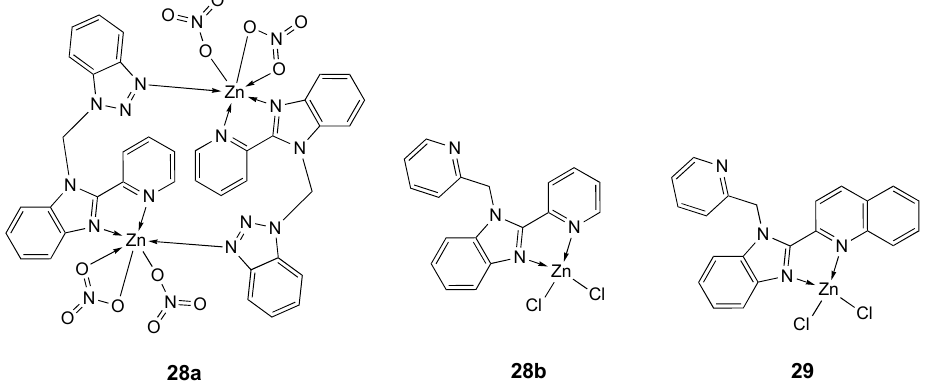
Figure 16. Structure of the zinc complexes 28a , 28b and 29 . Table 8. IC 50 values ( µ M) for zinc complexes 28a , 28b , ligands L 28a,b and reference cisplatin against di ff erent tumor cell lines after an incubation time of 72